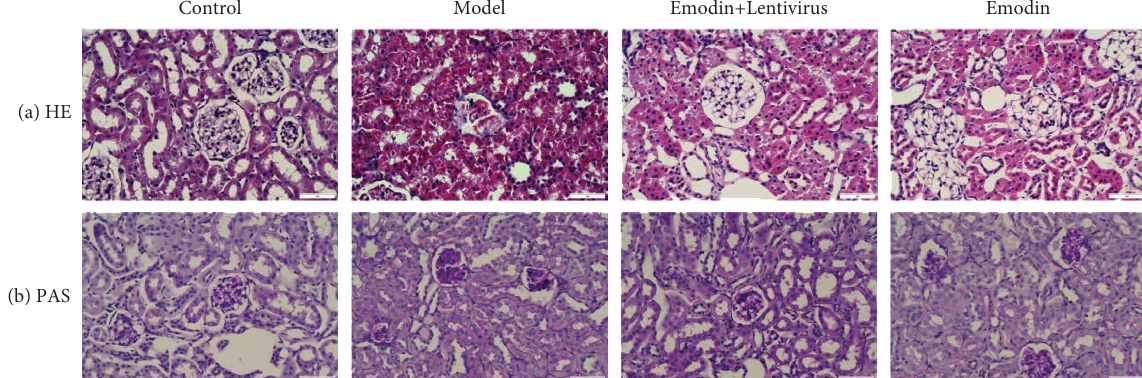
Figure 5: Efect of emodin on renal tissue injury in LN rats. (a) HE staining; (b) PAS staining. In PAS staining, the nucleus is blue, and the mesangial matrix, collagen fber, basement membrane, fbrin, vascular hyaline, amyloidosis, and other positive reactions can be bright pink. Scale bar, 50 μ